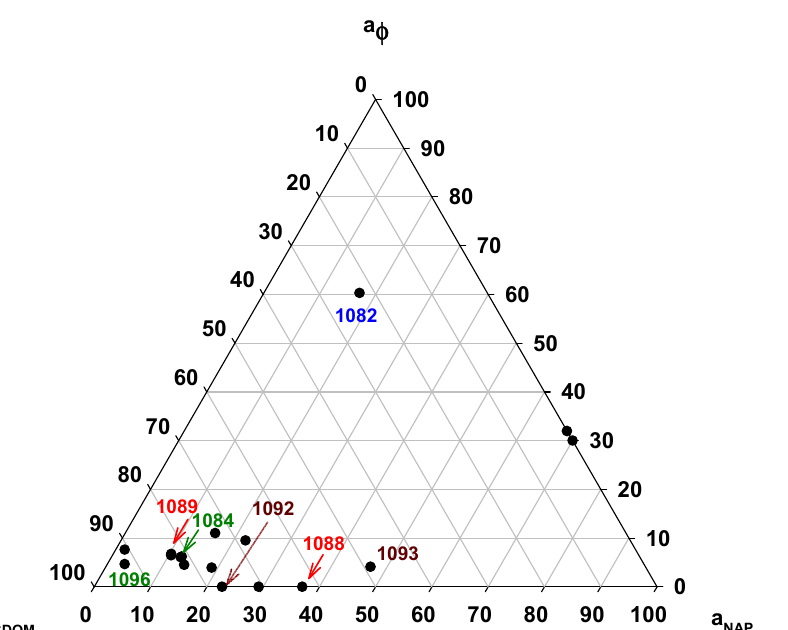
Figure 11. Absorption budget at 440 nm (relative contribution of CDOM, nonalgal particles and phytoplankton to the absorption coefficient) in the surface layer across PCB. St. 1088 and 1089: near the Normanby river mouth, St. 1092 and 1093: near the Kennedy river mouth, St. 1082: outer-shelf reef waters, and St. 1084 and 1096: repeat station in the mideastern section of PCB.